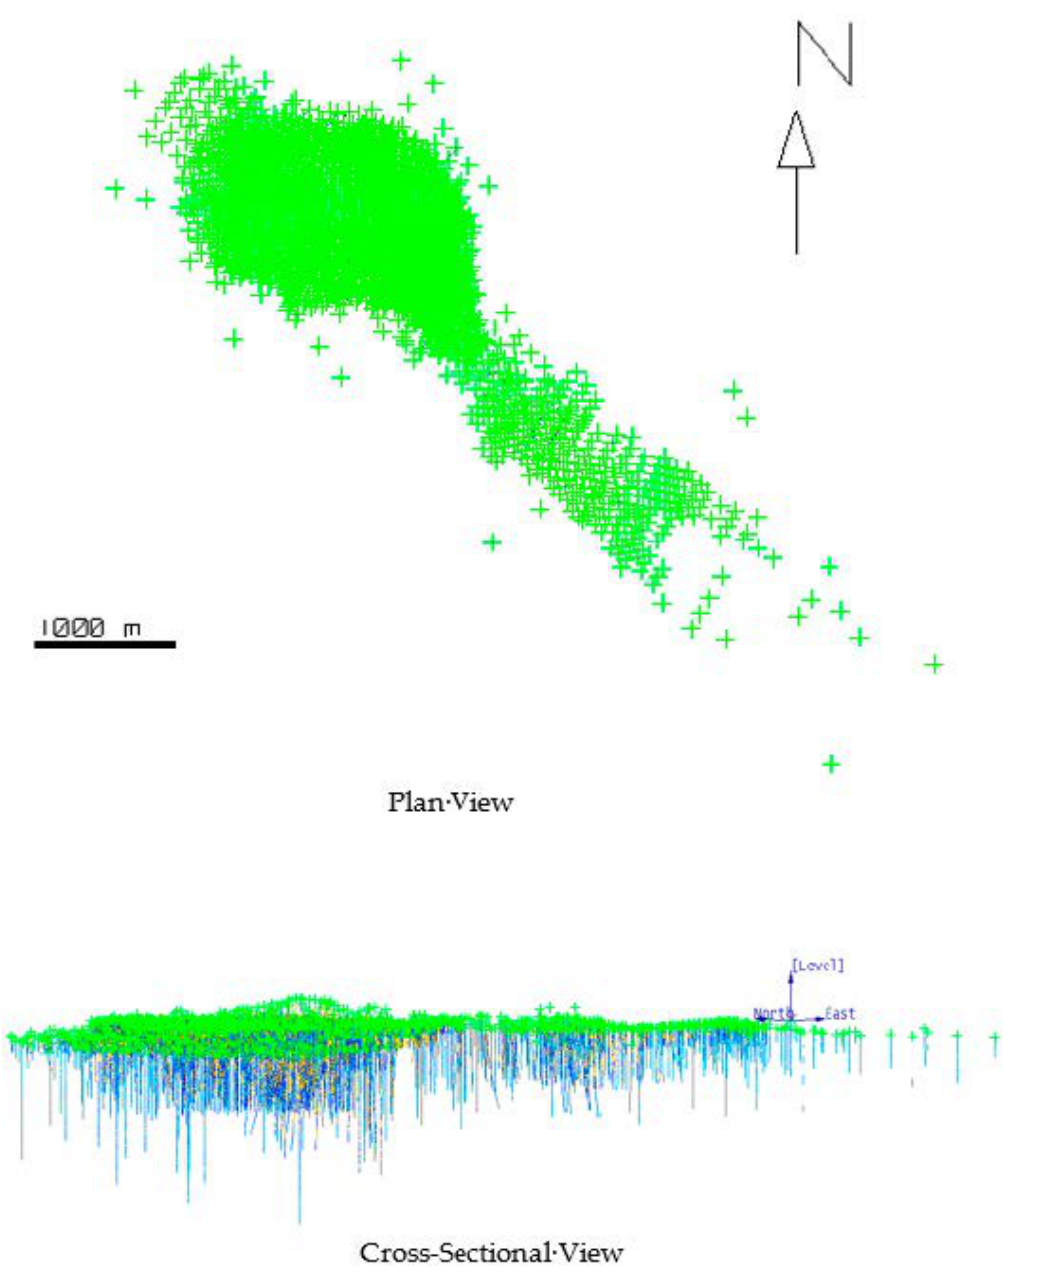
Figure 1. Plan view (top) and cross-sectional view of the 2823 drillholes. Arrow points north. Scale is shown in meters. A total of 90,033 drillhole segments are depicted.